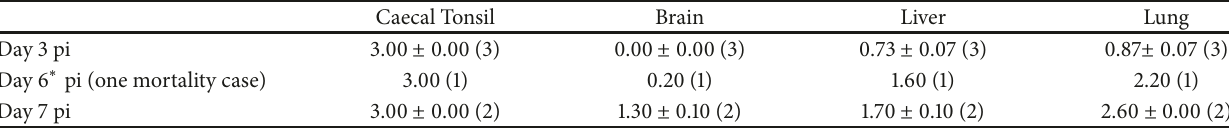
Table 3: Lesions scoring (0-3) induced by vNDV in HE stained caecal tonsil, brain, liver, and lung tissues on days 3, 6, and 7 pi. Caecal Tonsil Brain Liver Lung